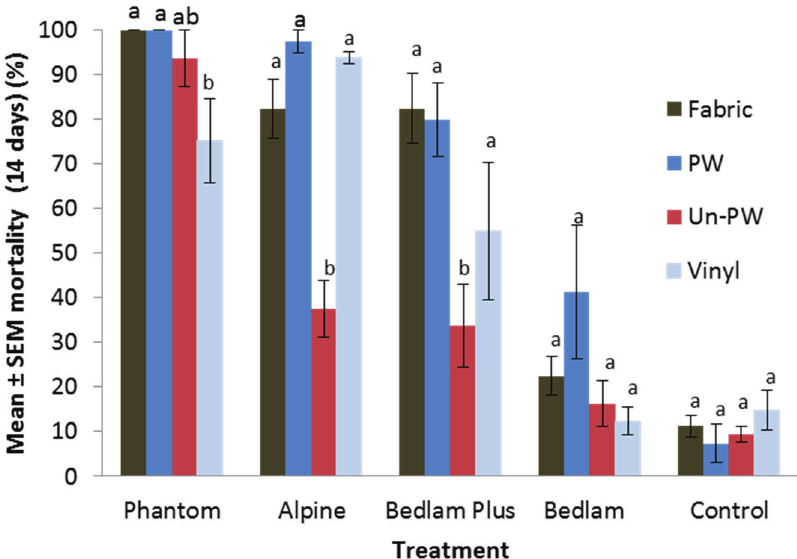
Figure 2. Effect of substrate type on residual efficacy of aerosol against Cimex lectularius . For each treatment, bars with the same letter are not significantly different (ANOVA, p > 0.05). PW: painted birch plywood; Un-PW: unpainted birch plywood.